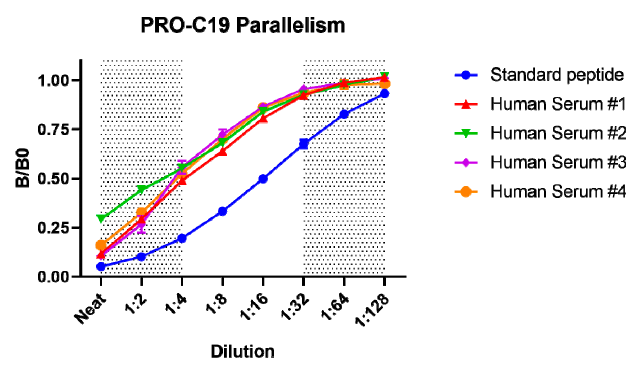
Figure 2. PRO-C19 parallelism. Inhibition curve for the standard peptide and human serum samples diluted twofold to assess linearity of dilution or parallelism. Signal is shown as a fraction of the background absorbance (B0), corresponding to assay bu ff er, as a function of the dilution steps. Error bars indicate standard deviation from duplicate measurements and greyed-out region indicates the limits of the linear range of the